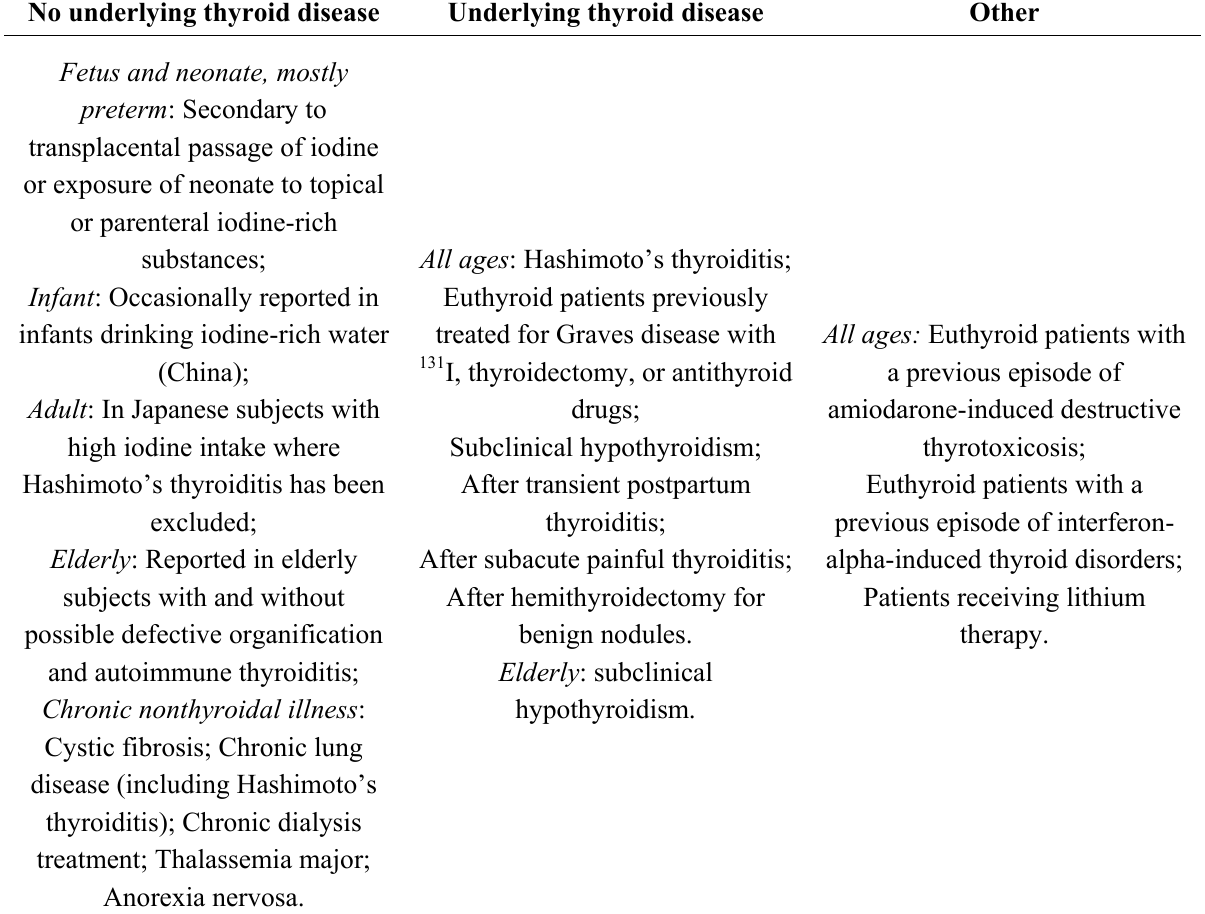
Table A1. Risk groups for iodine-induced hypothyroidism.